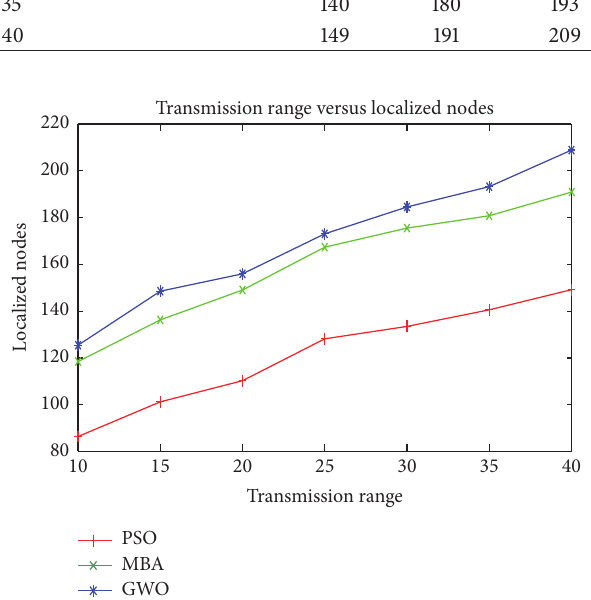
Figure 8: Comparison by varying Transmission range and obtained localized